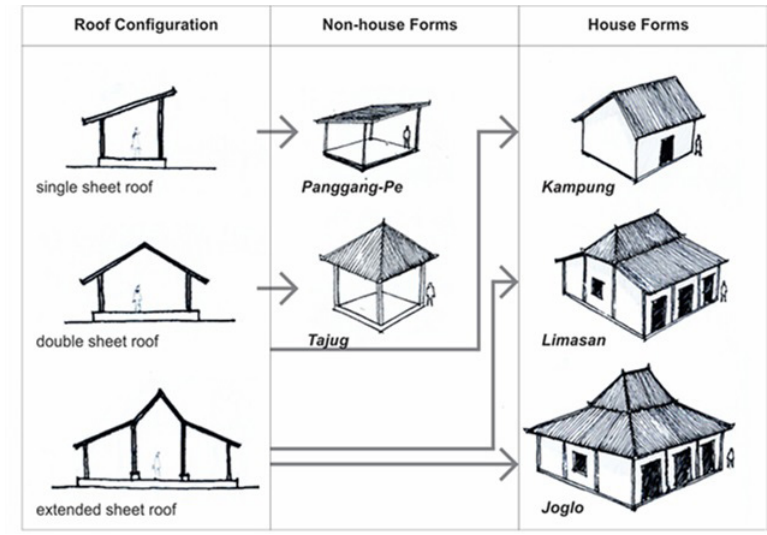
Figure 8. A typical plan of completed Joglo houses and form-spatial